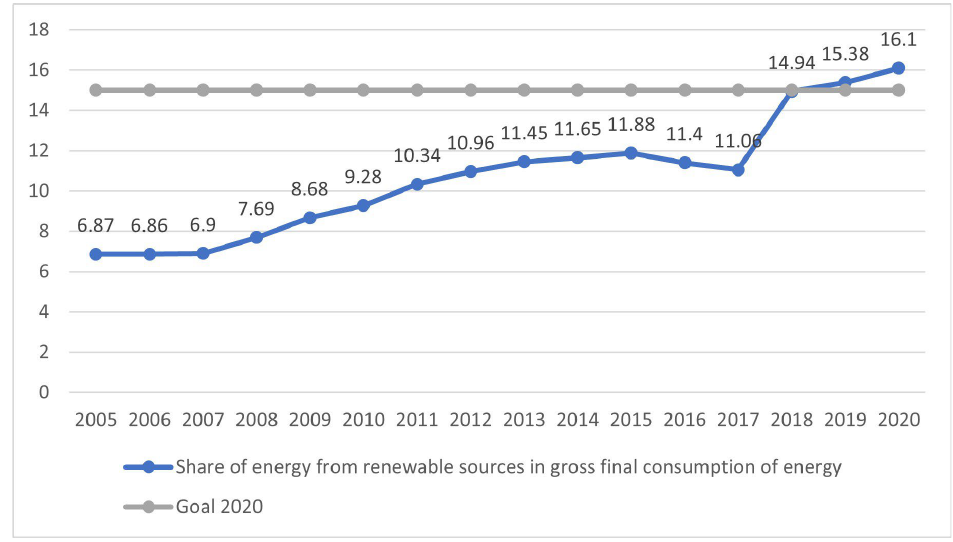
Figure 5. Share of electricity energy from RES in gross final consumption of energy in Poland, 2005–2020 (%). Source: SP, https://strateg.stat.gov.pl (accessed on 22 February